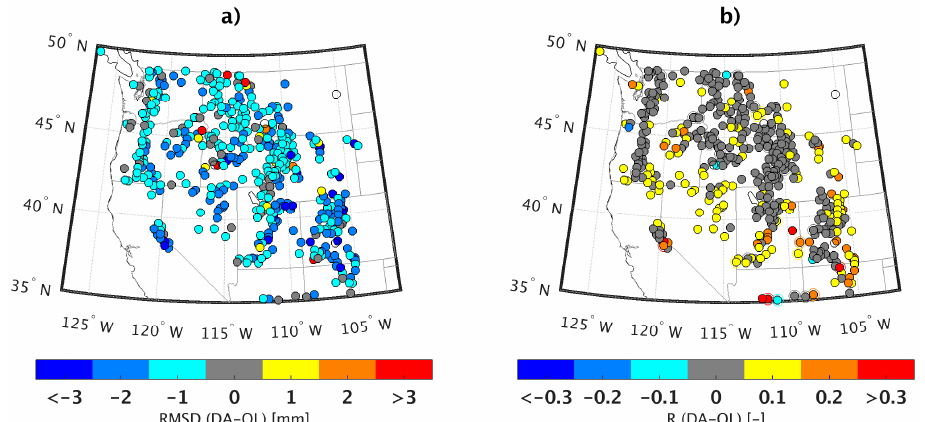
Figure 7. Changes in ( a ) RMSD and ( b ) correlation coefficient, R, from OL to DA (computed as DA − OL). The original DA and OL statistics were computed relative to daily SNOTEL SWE observations from 1 September 2001 to 1 September 2009.